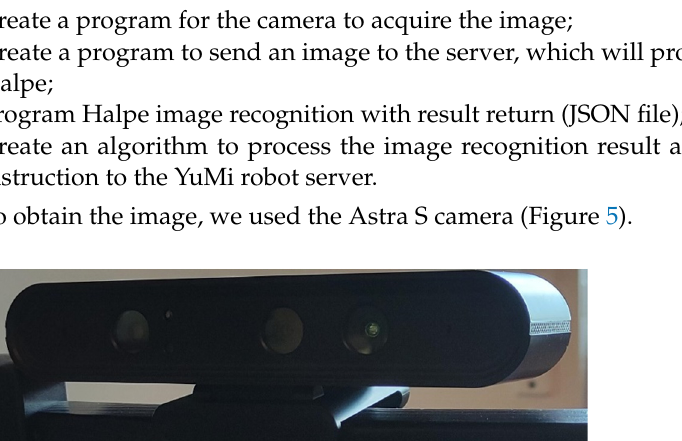
Figure 4. Representation of 21 points on the hand [20].